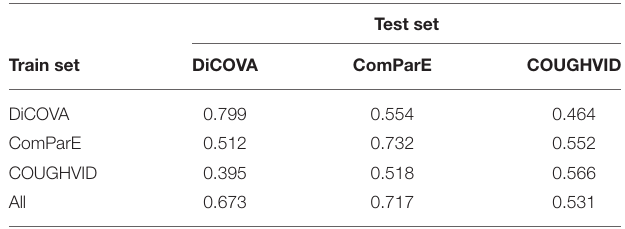
TABLE 4 | The results for cross dataset